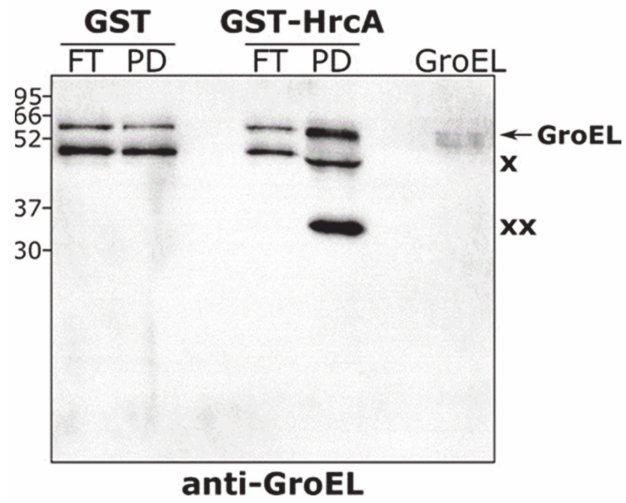
Figure 7. GST-pulldown assay carried out with C. jejuni total protein extracts. Immunoblot analysis of samples obtained from the GST-pulldown assay performed with C. jejuni total protein extract, stained with an anti-GroEL antibody. Samples recovered from the column containing either GST alone or GST-HrcA-Glutathione-agarose slurry (lanes labeled “PD”) were separated by SDS-PAGE and transferred on a PVDF membrane, together with samples that passed through the column, without interacting with baits (i.e., flowthrough samples, labeled “FT”). In addition, an aliquot of the purified GroEL protein was included as positive control (lane labeled “GroEL”). The intensities of the GroEL-specific bands in the GST- and GST-HrcA-PD samples were quantified using the ImageQuant software: the GroEL band in the GST-HrcA PD sample is 6.2-fold more intense than the same band in the GST PD control sample. The positions of the molecular mass standards are shown on the left. Symbols: : × and ×× indicate cross-reactive